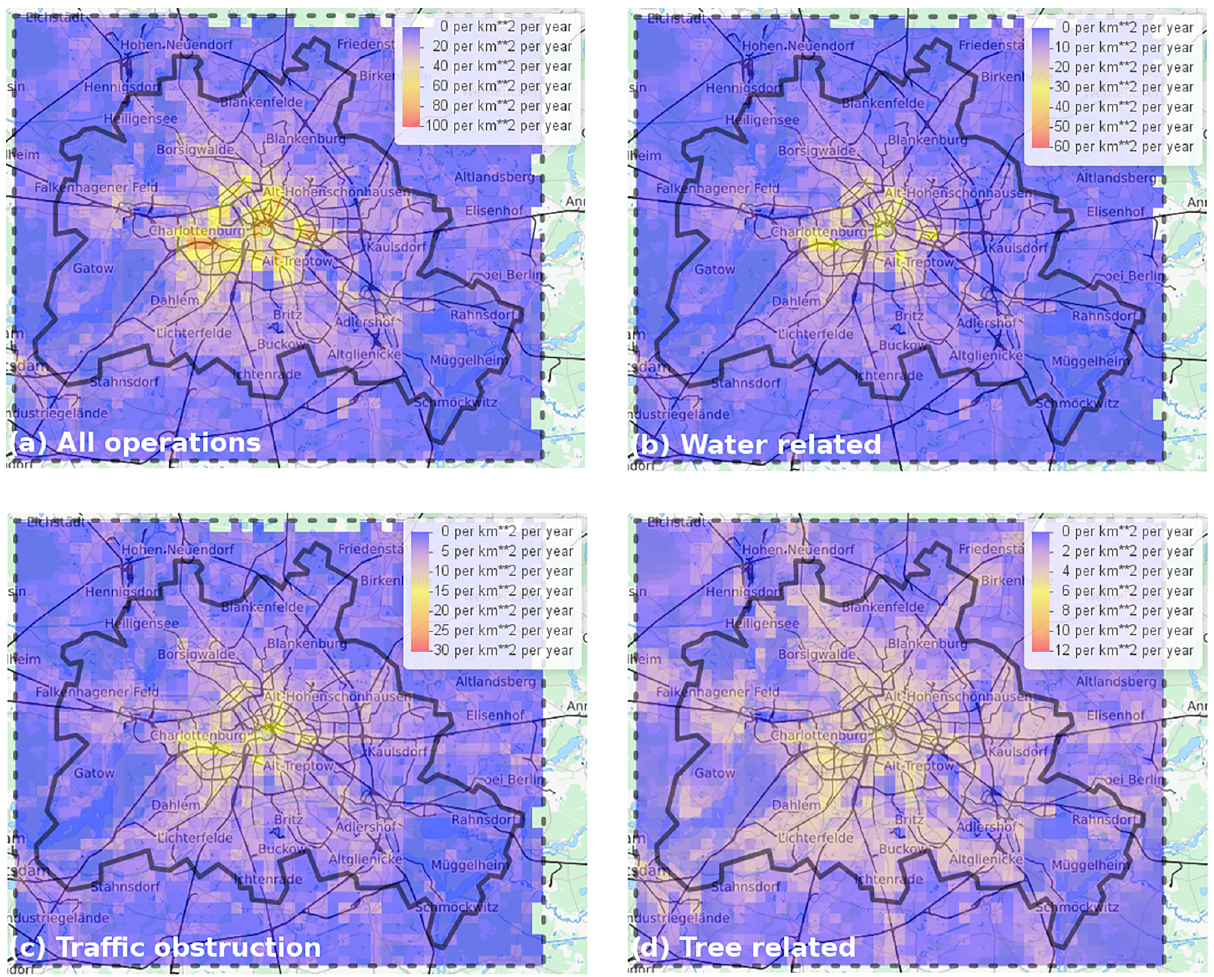
Figure 5. Modelled mean yearly density of fire brigade operations (units: operations per square kilometre per year). Results are shown for the model including all operations disregarding their type (a) , for water-related operations (b) , for traffic obstructions (c) and for tree-related operations (d)